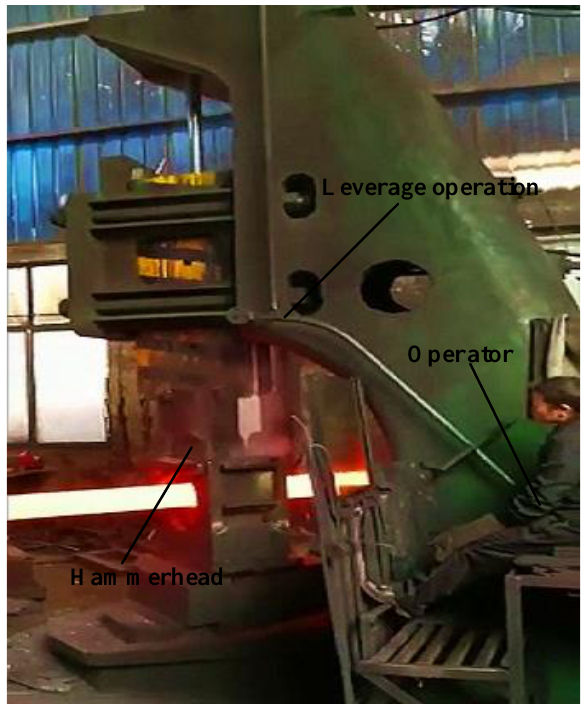
Figure 1. Site operation of free forging hammer.